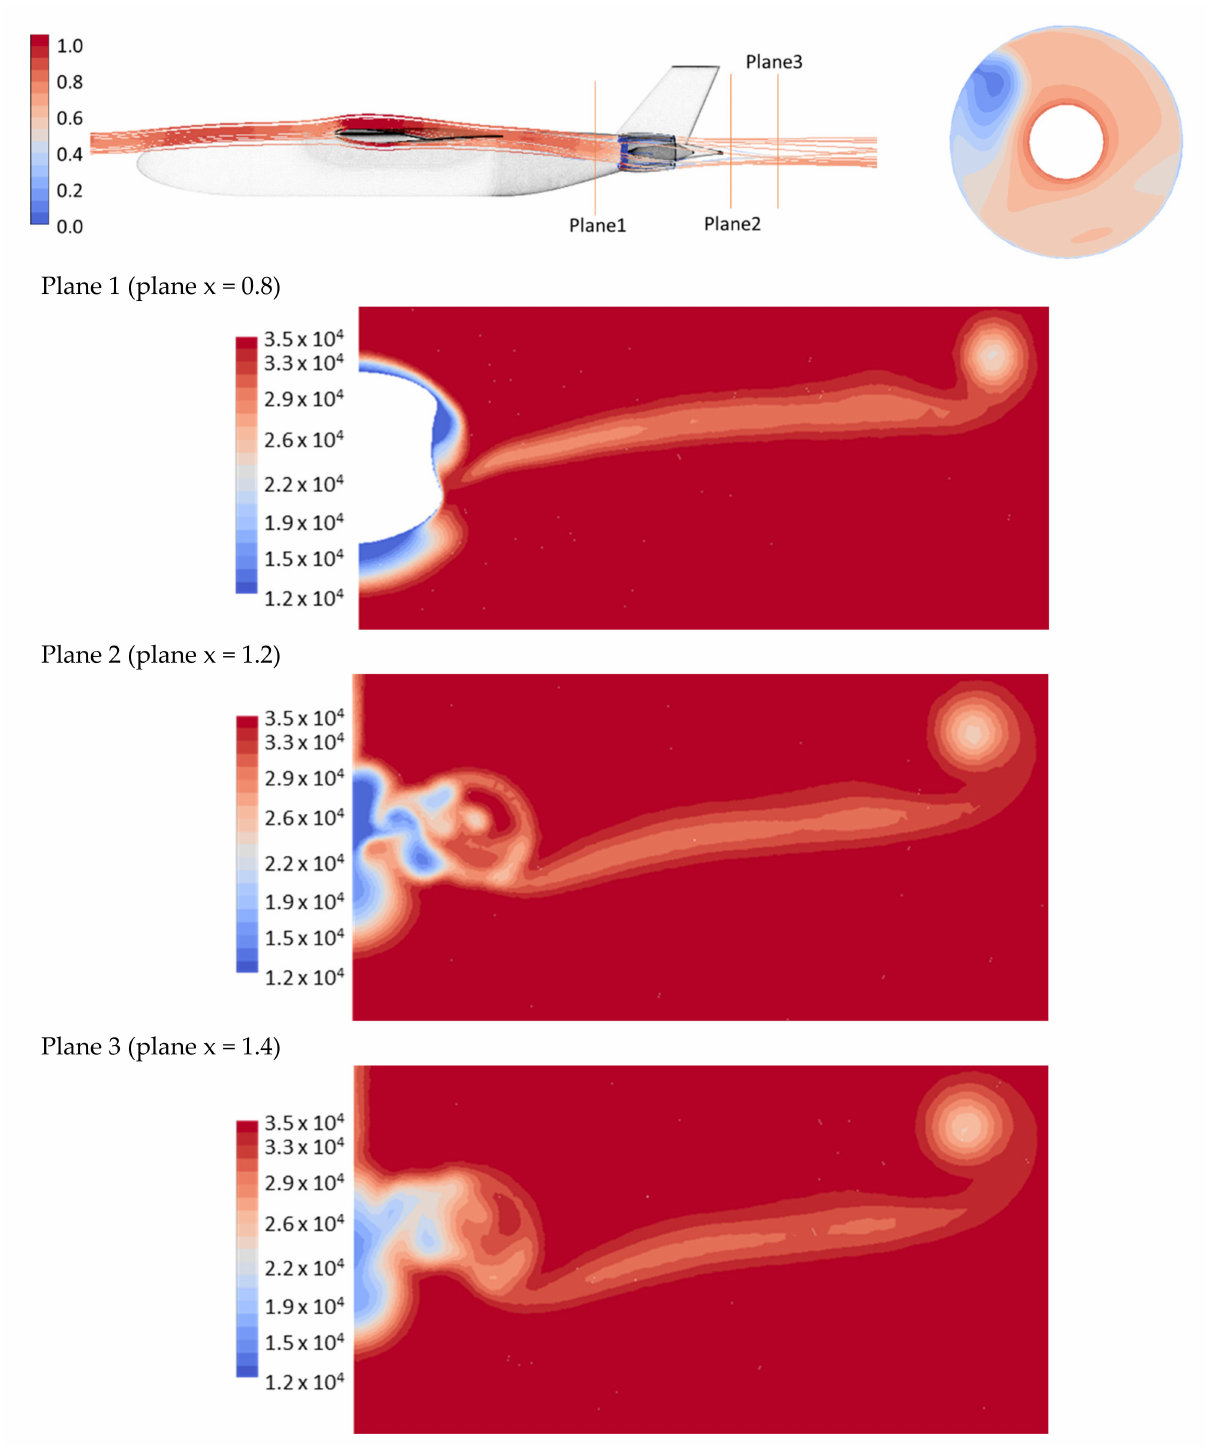
Figure 19. Pathlines towards the inlet of the engine ( top left ), the contour of the Mach number in the plane of fan inlet ( top right ), and the contours of the total pressure [Pa] in the planes of interest ( from the second to the last : Plane 1, Plane 2 and Plane 3), results from the 3D simulation of high wing